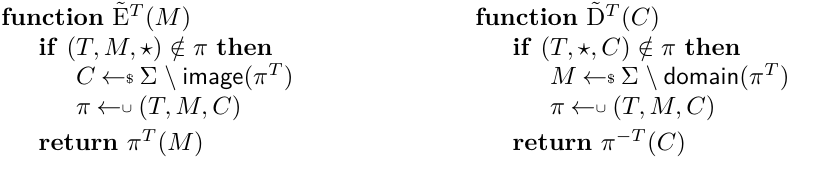
Figure 3: Modelling the tweakable blockcipher ˜E with inverse ˜D via lazy sampling.